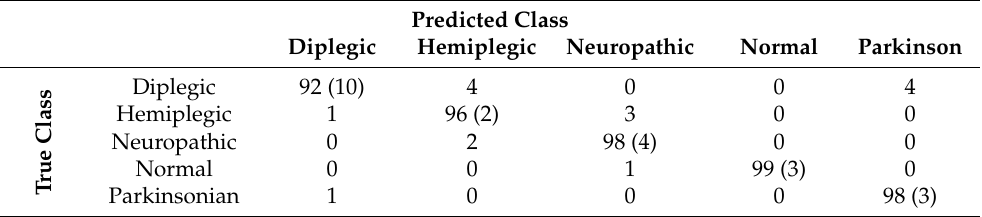
Table 1. Cross-validation results of the proposed spatiotemporal deep learning gait classification framework: confusion matrix with classification accuracies (and the standard deviation shown between parentheses), in %, on the GAIT-IT dataset; the overall average accuracy was 96.5%. Predicted Class Diplegic Hemiplegic Neuropathic Normal